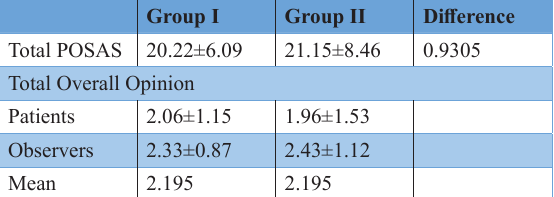
Table 5. Comparison of Total POSAS scores and Total Overall Opinion of observers and patients Group I Group II